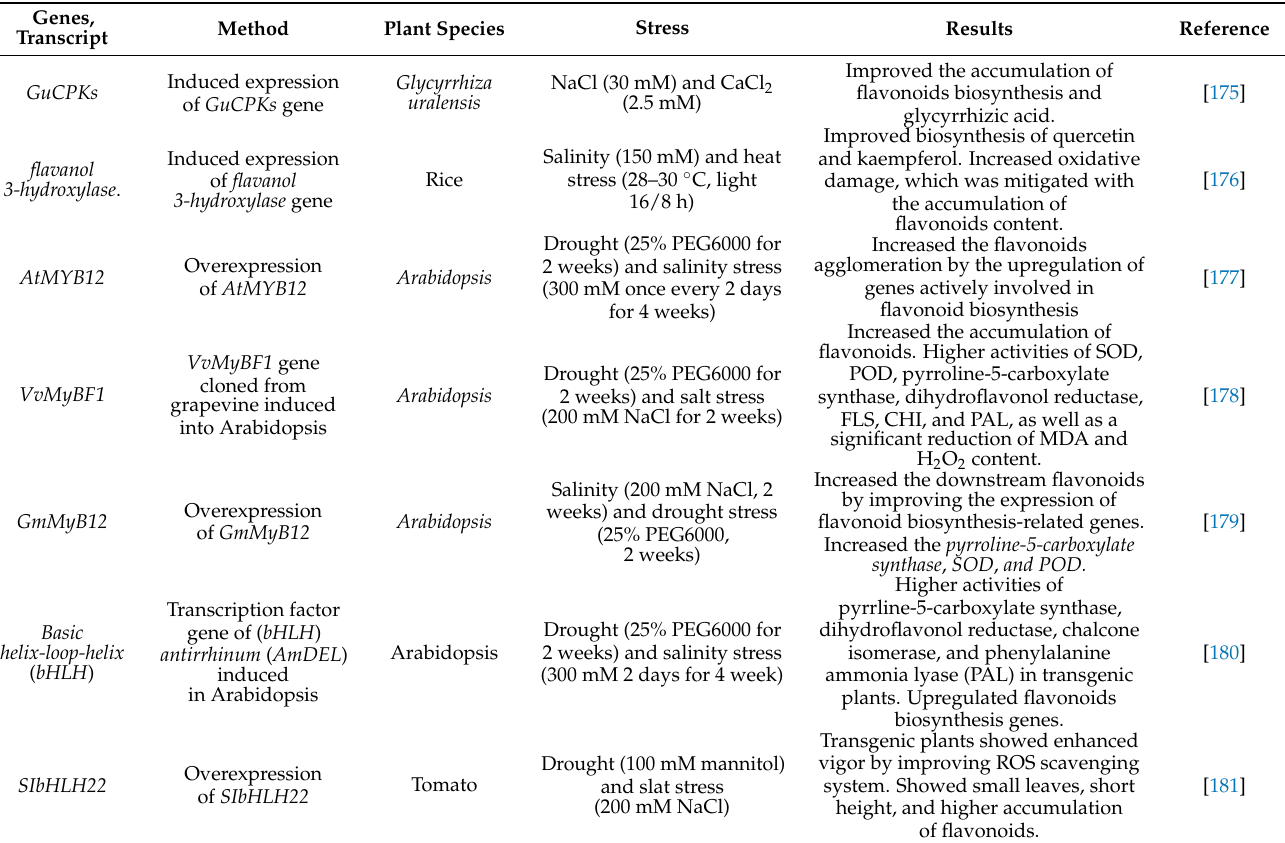
Table 4. Molecular and genetic approaches in tailoring flavonoids biosynthesis and regulation under abiotic